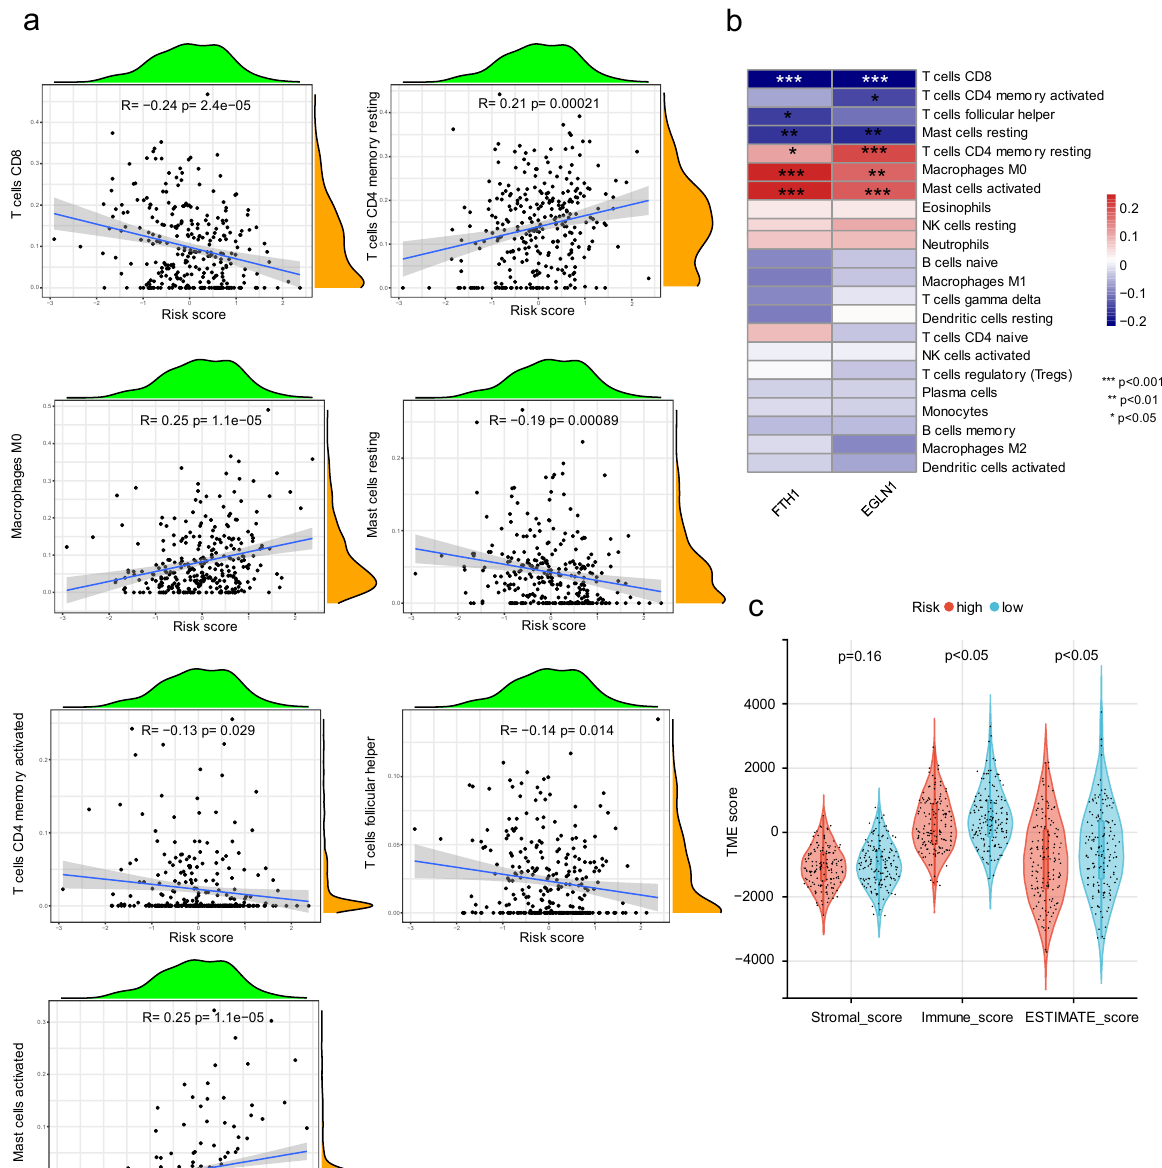
Figure 9. Relationship between risk score and immune infiltration. ( a ) Analysis of immune cell types associated with risk score (R represents Pearson correlation coefficient; p represents the significance levels); ( b ) heatmap of correlation between expression levels of FTH1 and EGLN1 and immune cells; and ( c ) immunity scores observed within different groups of risk scores. ( p < 0.05 *; p < 0.01 **; p < 0.001 ***).